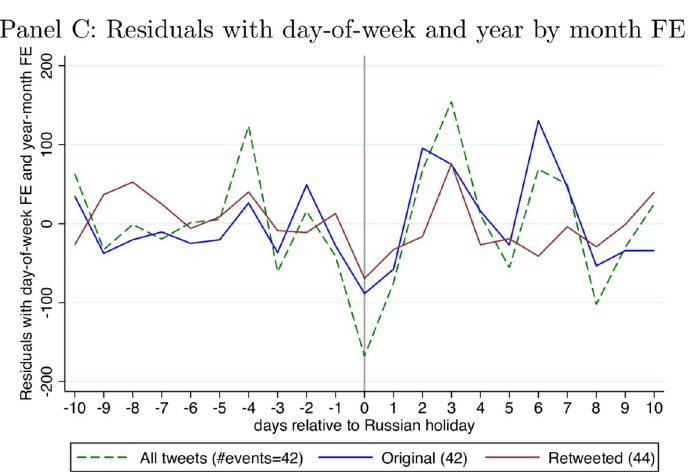
Fig 1. Event study of wave 1 tweets (day shift) around Russian holidays 2012–2017. (We drop top 10 busiest days for each category (all, original, retweeted tweets) 2012–2017, and only keep holiday events with complete data over the 21-day window. This results in a smaller number of events than 48 (8 events per year over 6 years) and a different number of events for each category, reported in parentheses. For Panel A, we calculate the simple average of tweets on each event day. For Panel B and C, we add day-of-week FE and year-month FE and calculate the average of predicted residuals). Panel A: Raw data. Panel B: Residuals with day-of-week FE. Panel C: Residuals with day-of-week and year by month